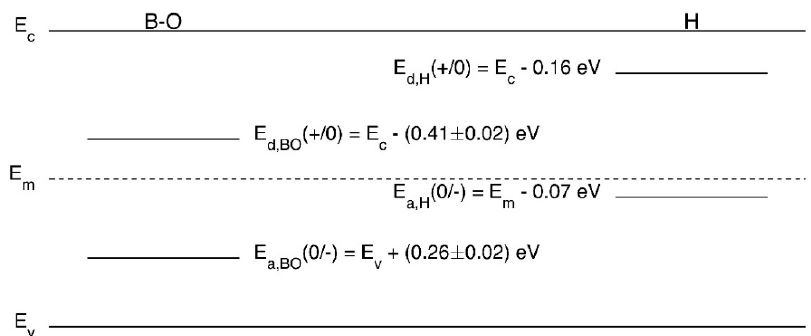
Figure 2. Energy level diagram for B-O defects and interstitial hydrogen showing the donor (E d ) and acceptor (E a ) levels relative to the conduction band (E c ), valence band or mid-gap (E m ).